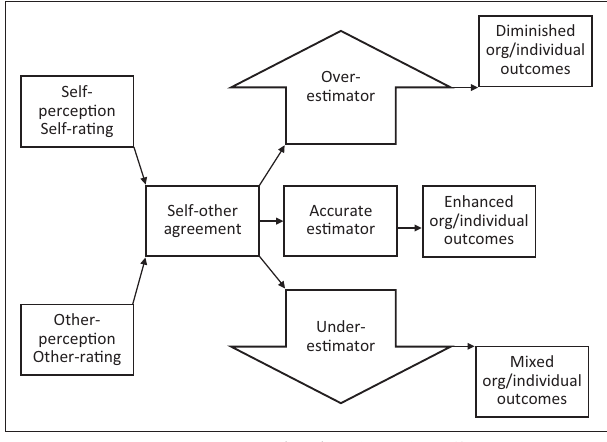
FIGURE 2: A model of self-perception